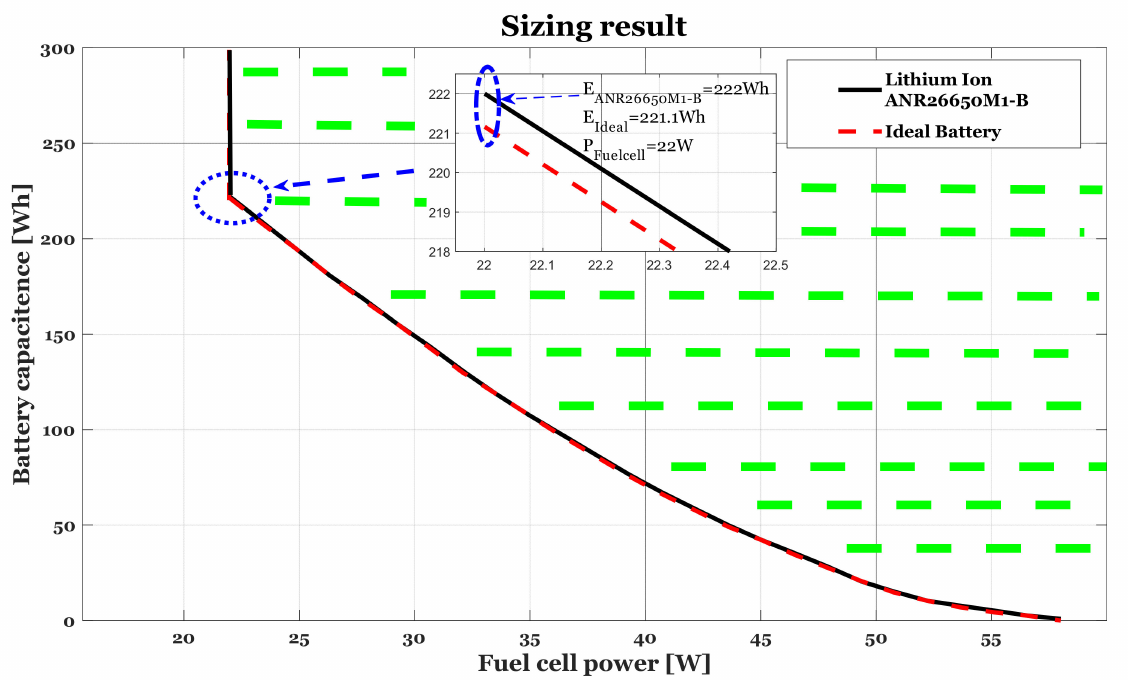
Figure 14. Sizing results.